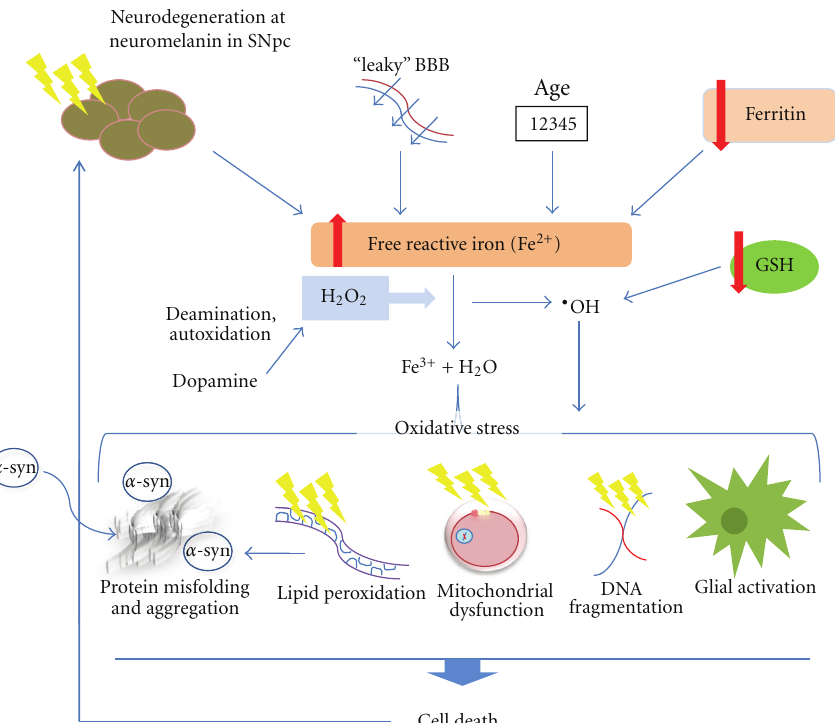
Figure 1: Iron-mediated cell death in PD. Reduced storage capacity in PD due to decreased ferritin expression and degeneration of nigral melatonin-containing neurons causes an increase in the reactive Fe 2+ iron pool. Age-related increases in iron and a leaky BBB cause further iron accumulation. The transfer of the free iron to ferric iron, Fe 3+ , in the hydrogen peroxide-mediated Fenton reaction produces the highly toxic hydroxyl radical. A compromised level of glutathione exacerbates the levels of free radicals, whilst the deamination and autoxidation of dopamine produces further H 2 O 2 . The subsequent oxidative stress can then elicit a range of cytotoxic reactions including protein misfolding, lipid peroxidation (which, in turn, can cause α -synuclein aggregation), mitochondrial dysfunction, and activation of glial cells. These various insults can induce cell death by apoptosis, causing further